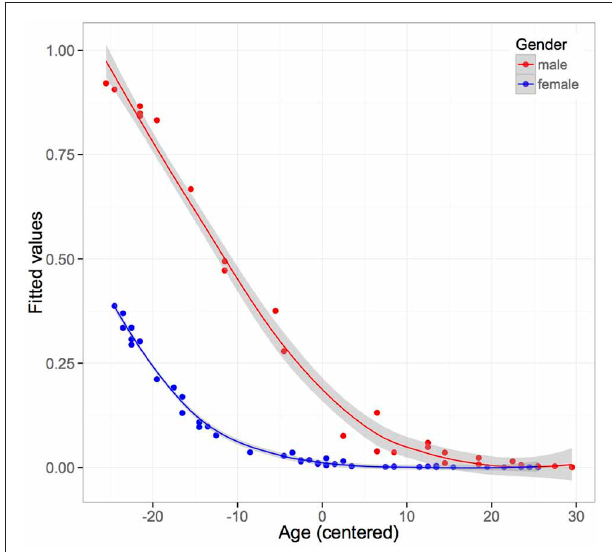
FIGURE 4 | Fitted values from binomial logistic regression on video game experience. Male and younger participants reveal more videogame experience than older and female participants ( n = 73).